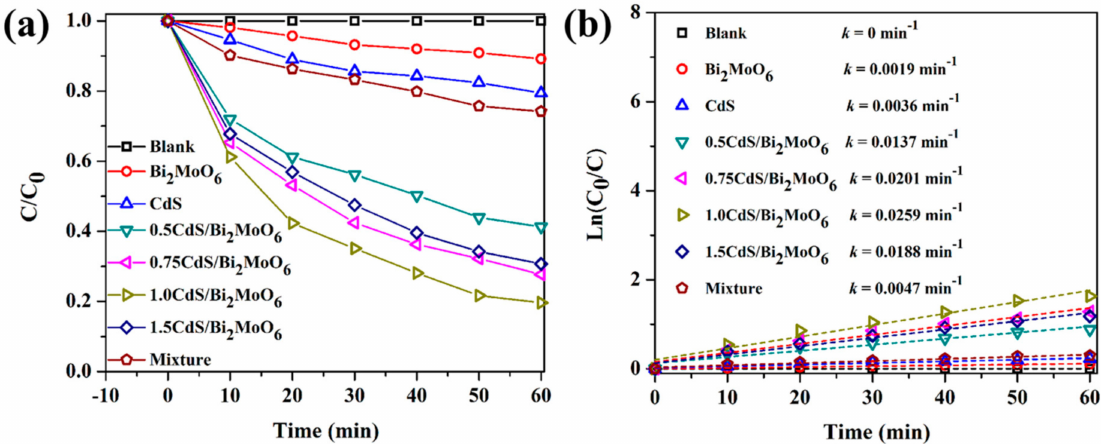
Figure 4. ( a ) The photo-degradation efficiency against LEV (20 mg L − 1 , 100 mL) by different catalysts (35 mg). ( b ) Kinetic modeling for LEV removal over different